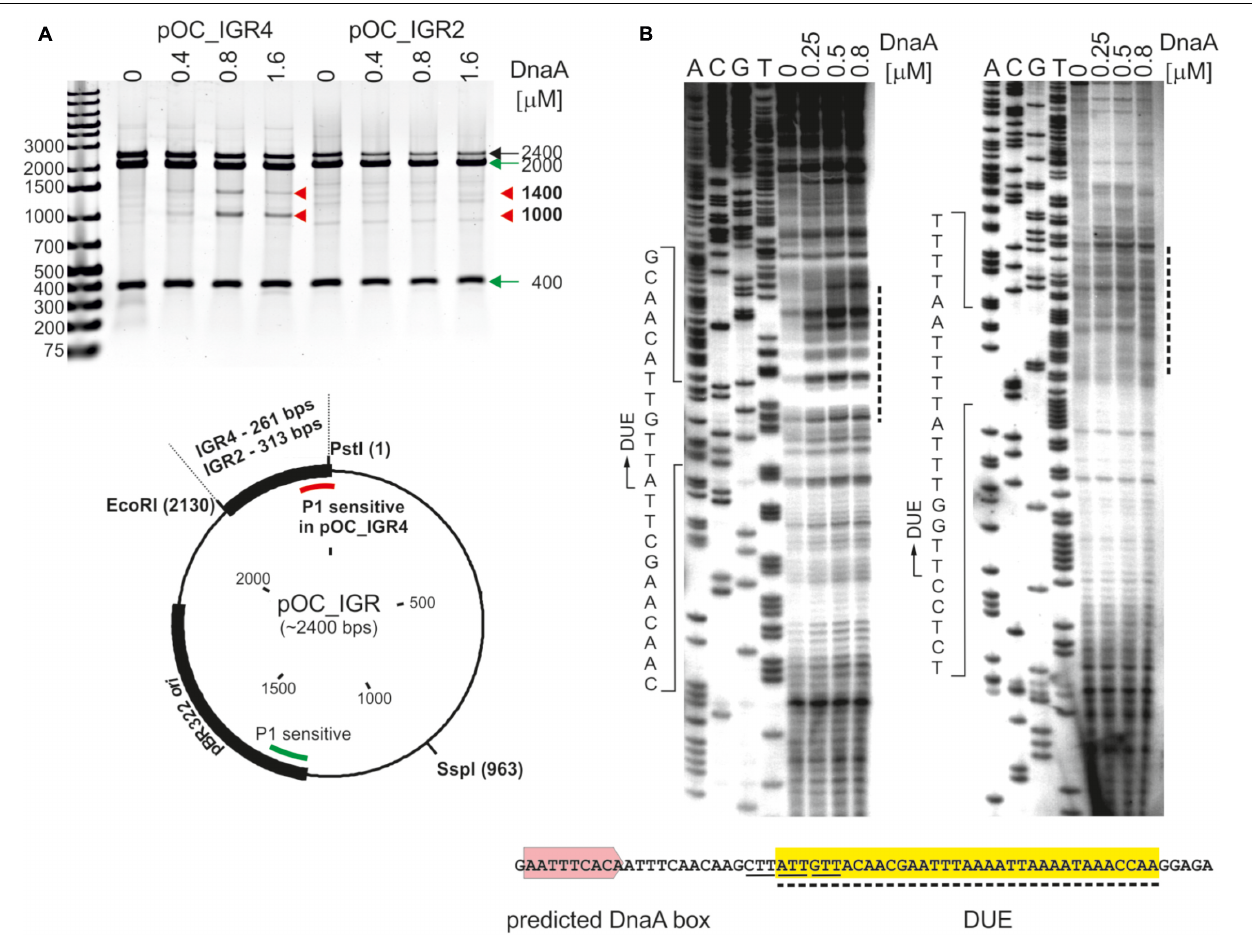
FIGURE 3 | Identification of the DUE in C. jejuni oriC . (A) Supercoiled plasmids pOC_IGR2 and pOC_IGR4 were incubated with the indicated amounts of 6HisDnaA and successively digested by P1 nuclease and SspI. Digested plasmids were resolved in 1% agarose gel, and the fragments resulting from DnaA-dependent unwinding are indicated by red arrowheads next to the gel, while the DNA fragments resulting from DnaA independent unwinding within the plasmid pBR322 ori site are indicated by green arrows. A map of the pOC_IGR plasmids used in the P1 nuclease assay is presented below the gel. The IGR regions, pBR322 plasmid origin of replication and positions of the most important restriction sites are marked. P1-sensitive DnaA-dependent unwinding is distinguished from DnaA-independent by red and green lines, respectively. (B) The supercoiled plasmid pOC_IGR4 was incubated with the indicated amounts of 6HisDnaA, digested by P1 nuclease and used as a template for PE reactions with 32 P-labeled primers C1 and C2. Dashed lines on the right of the PE gel indicate the nucleotides susceptible for the P1 nuclease treatment, while the boundaries of the DUE are marked with continuous-line arrows next to the presented sequences. The sequence of the DUE (dashed line, yellow shadowing), the degenerated DnaA-trio motif (solid line) and predicted DUE-proximal DnaA box (light-red) are presented below the PE gel. Yellow shadowing is used to mark DUE in subsequent